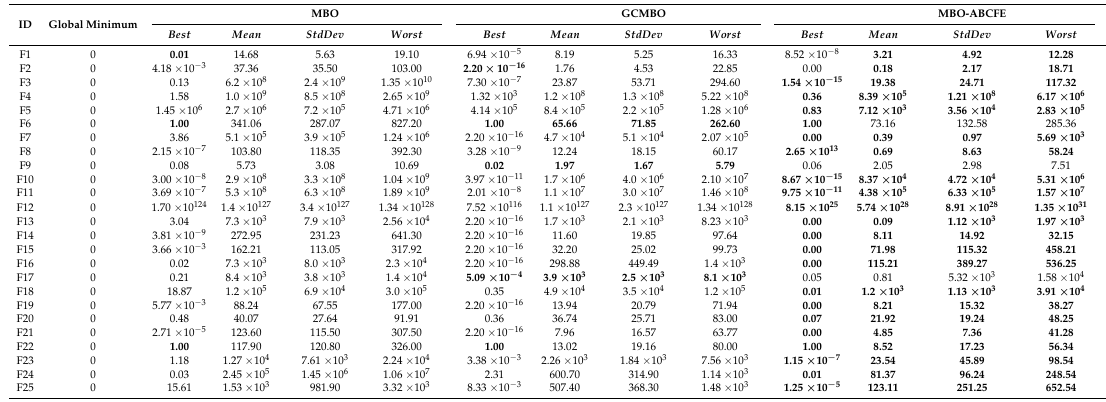
Table 4. Scientific results of MBO, GCMBO, and MBO-ABCFE on 40-dimensional problems averaged over 50